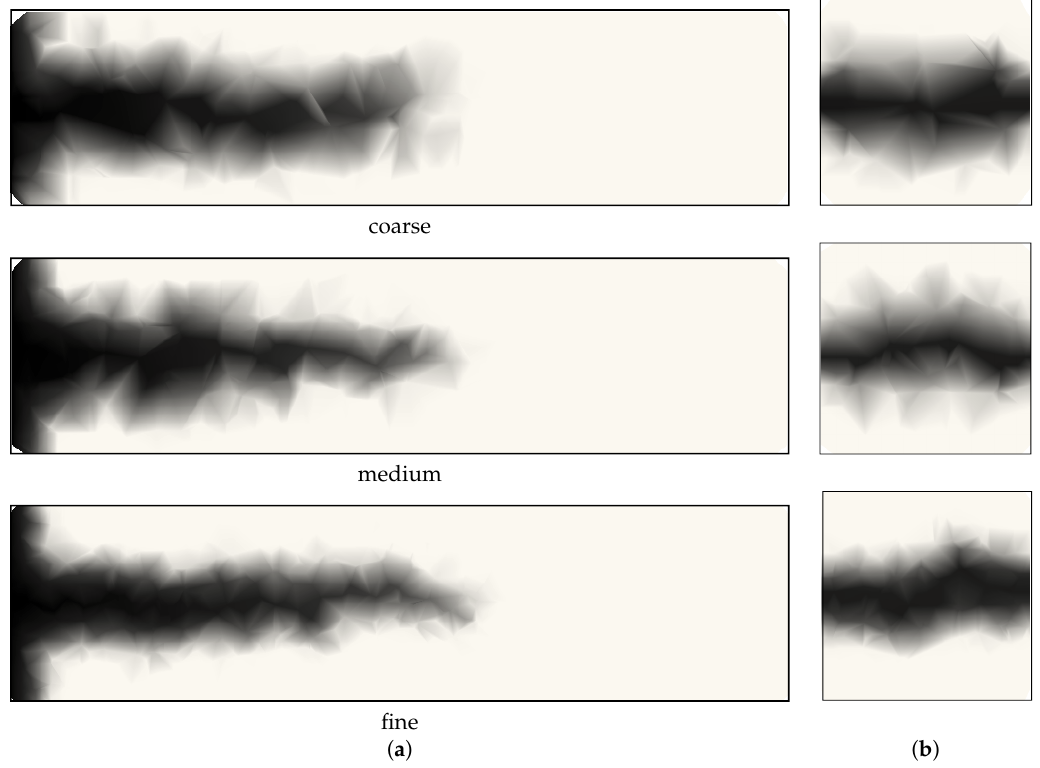
Figure 14. Contour plots of capillary suction P c at 3.33 h for the ( a ) x – z plane at y = 0.125 m and ( b ) y – z plane at x = 0.3